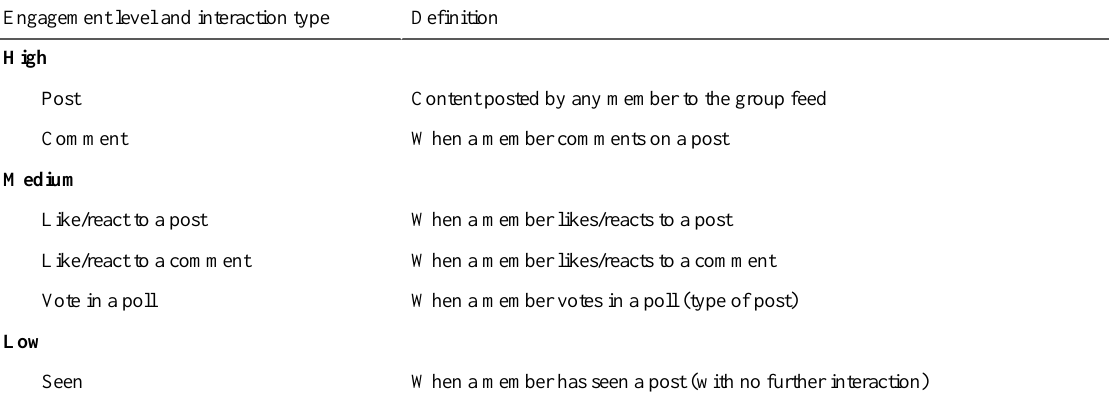
Table 1. Types of